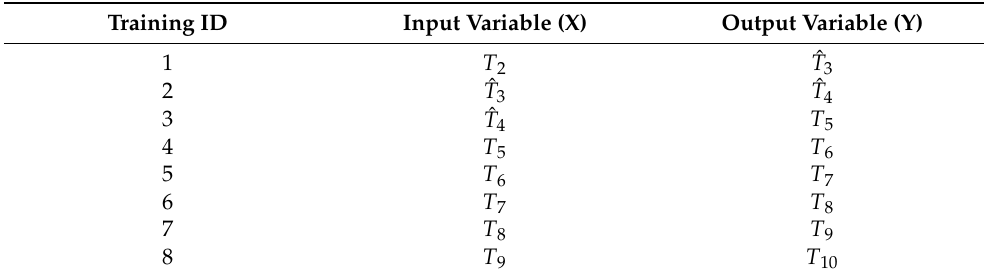
Table 4. An example of a training database with outlier